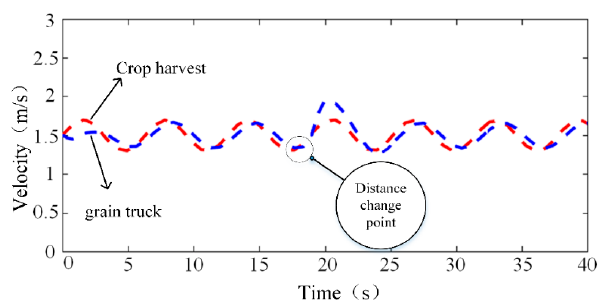
Figure 8. Changes in vehicle distance caused by changes in vehicle crop weight.